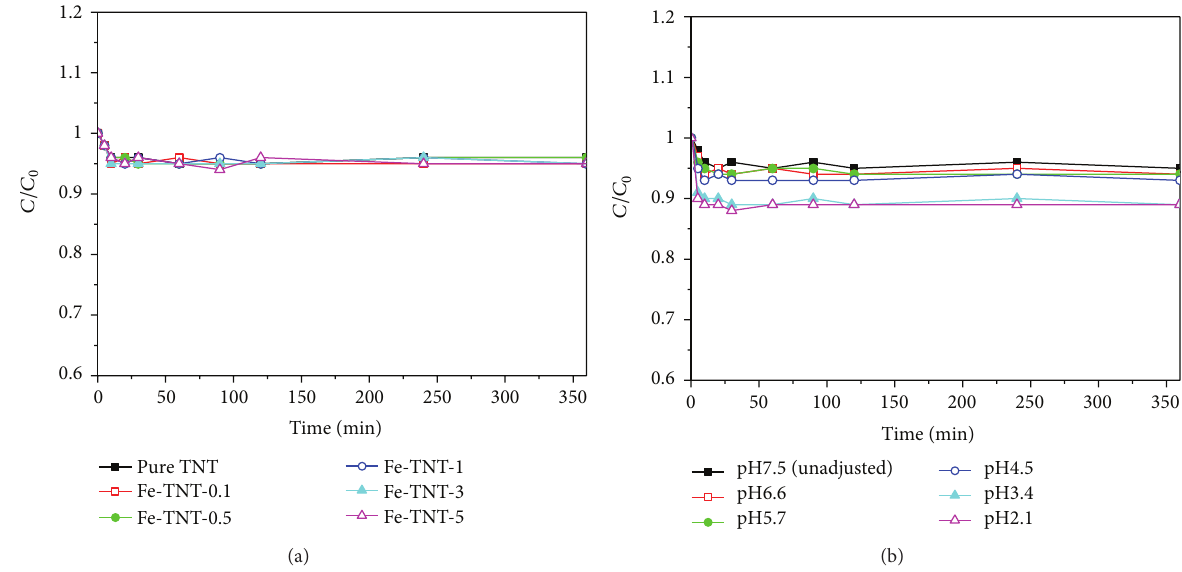
Figure4:Adsorption/desorptionequilibriumofMOonthesamplesurfaces((a),differentcatalysts;(b),differentpH)atdifferentmagnetically stirred time in the dark.